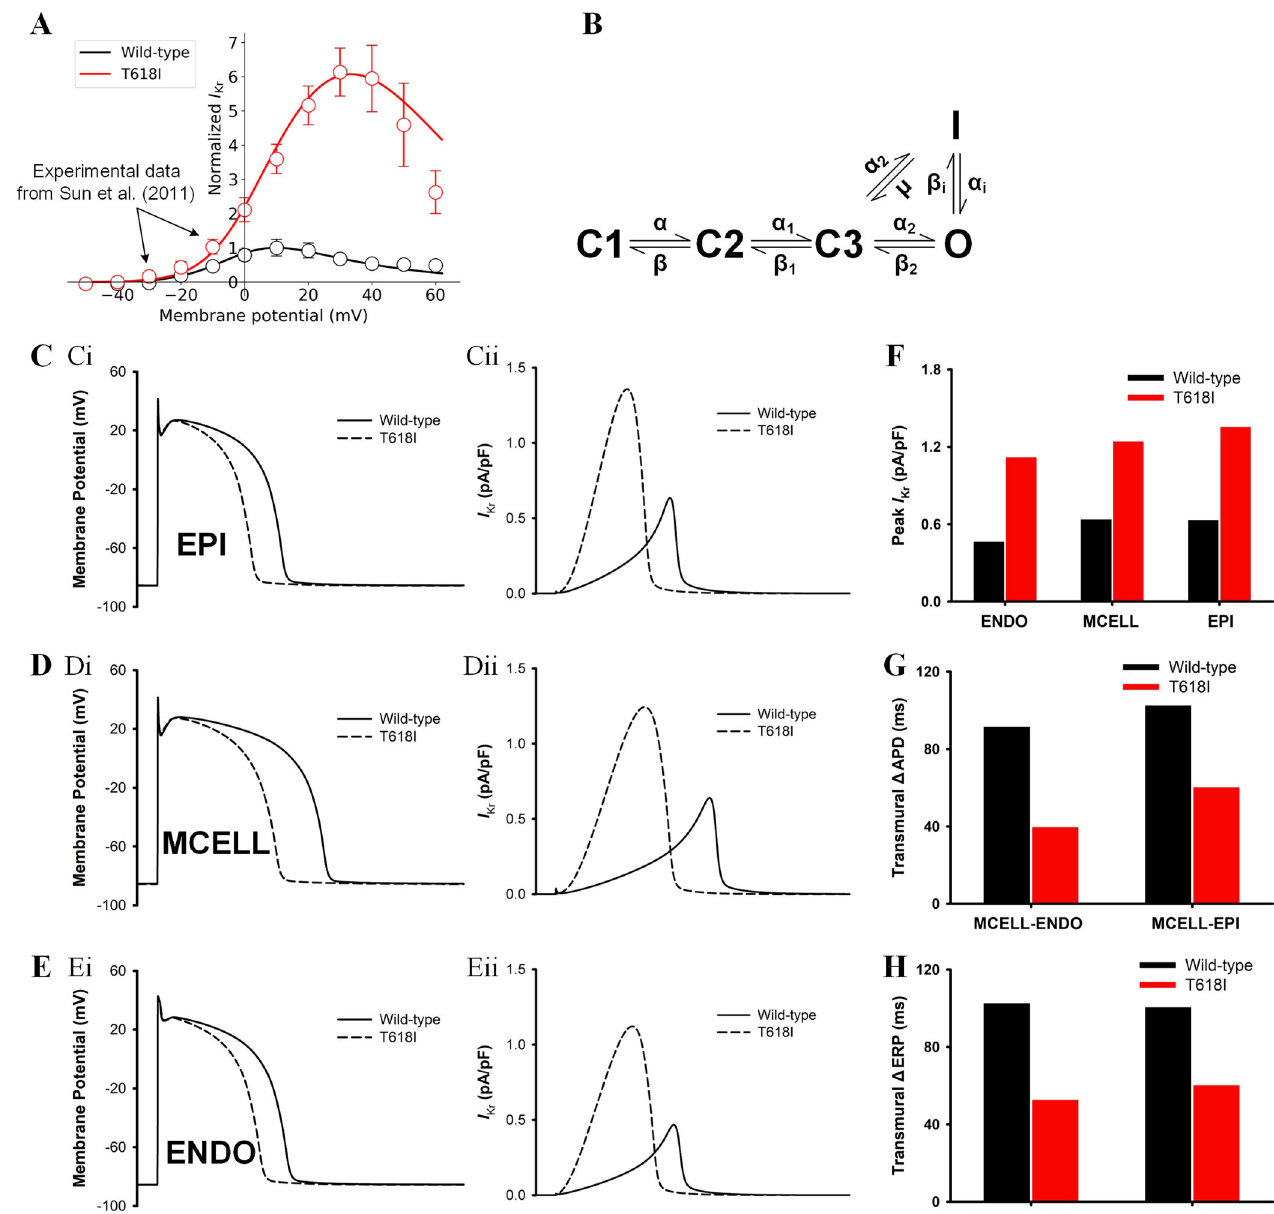
Fig. 1 Simulation results at ion channel and cellular levels. A The fi tted current – voltage (I – V) curves in wild-type (black) and T618I (red) conditions using I Kr Markov chain models. Experimental data from Sun et al. 11 (their Fig. 4B). Error bars represent the standard error of measurement (SEM). B The I Kr Markov chain model. C Steady-state (1.25 Hz) action potentials (Ci) and the corresponding I Kr (Cii) for EPI cells. Solid and dashed lines represent wild-type and T618I conditions, respectively. D Steady-state action potentials and the corresponding I Kr for MIDDLE cells. E Steady-state action potentials and the corresponding I Kr for ENDO cells. F The comparison of the peak I Kr in wild-type and T618I conditions. G The comparison of transmural APD differences. H The comparison of transmural ERP affected one among three cell types. The differently reduced APD also led to the remodeling of transmural dispersion of repolariza- Kr Markov chain model was then incorporated into the tion. The membrane potential difference of APD ( Δ APD) between Tusscher-Noble-Noble-Pan fi lov (TNNP06) model to explore the ENDO and MCELL was decreased by almost 60% from 91.7 to effects of the KCNH2 T618I mutation at the cellular level. Steady- 39.7 ms, and the Δ APD between EPI and MCELL was also reduced state APs of different cell types in wild-type and T618I conditions, from 102.7 to 60.3 ms. Likewise, transmural differences of ERP as well as their corresponding I Kr , are presented in Fig. 1. ( Δ ERP) were decreased accordingly (Fig. 1G, H). Simulation results suggested that the T618I mutation accelerated the repolarization phase of action potentials through enhancing In fl uences of the KCNH2 T618I mutation on APD and CV restitution I Kr , which led to abbreviated ventricular APD and ERP. properties and the rate adaption of QT interval . Clinical reports Though ERP was shortened in all cell types, this effect was not have demonstrated a reduced rate adaption of QT in SQTS patients the same in different cell types, with MCELL being the most